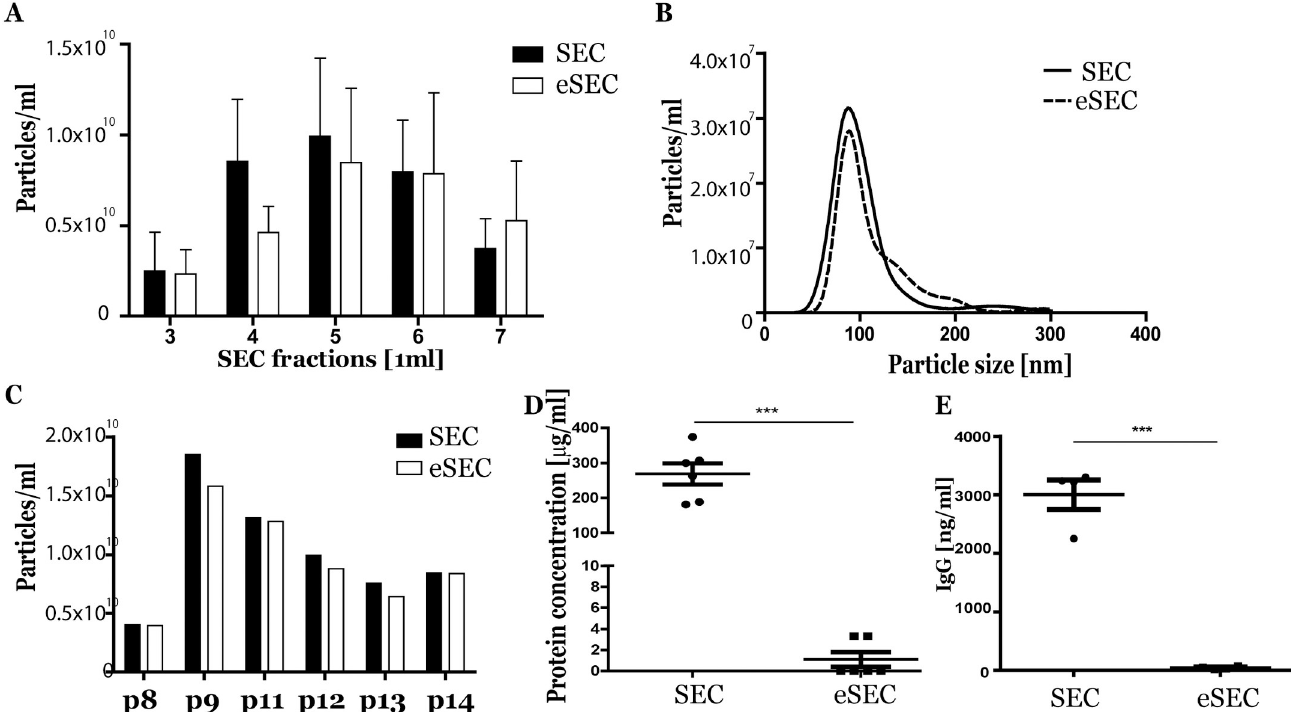
Fig 4. pEV isolation by extended SEC column shows less protein impurities. From 500 μ l pfp obtained from 6 RA patients pEVs were isolated by SEC or eSEC and particle concentration was measured in eluted fractions 3–7 by NTA (A). Compared SEC and eSEC size-profile from 1 representative pEV sample (fraction 5) is shown (B). Particle concentration of SEC or eSEC isolate pEVs in fraction 5 (n = 6) were measured by NTA (C). Protein content was measured by micro-BCA protein assay of each SEC or eSEC isolated pEV sample (D) and own IgG levels were measured by ELISA (E). Statistically significant differences in protein content were determined by paired T-test, ��� p <